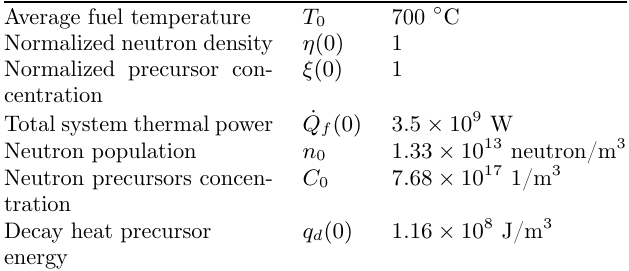
Table 4. Initial conditions for the coupled